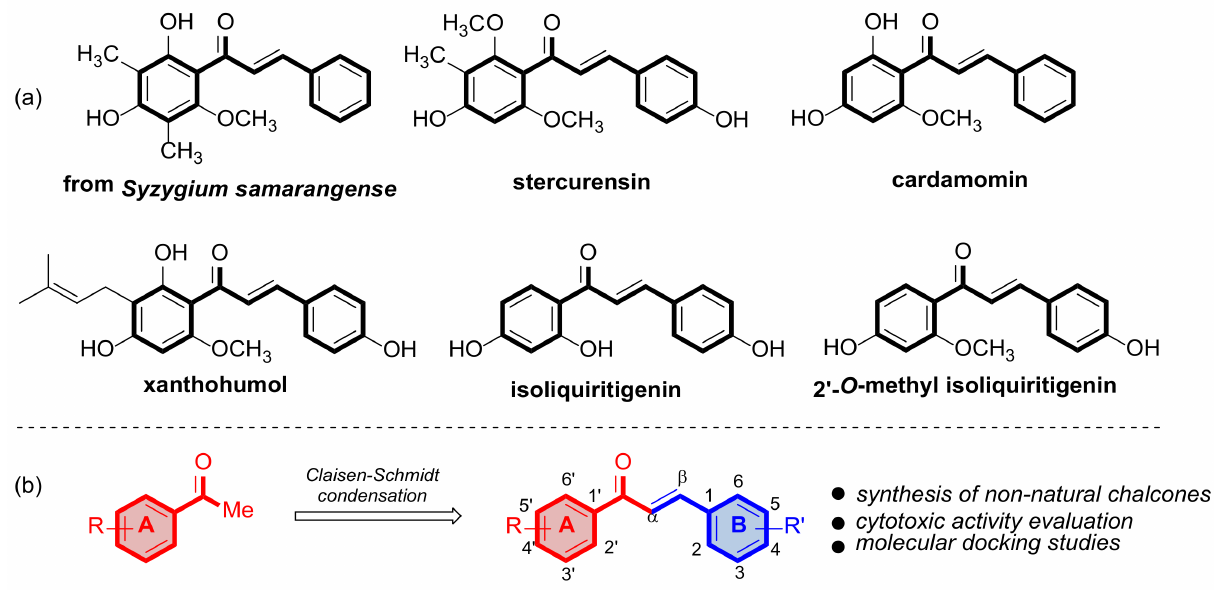
Figure 1. ( a ) Chalcones of natural origin with antiproliferative activity in various cancer lines. ( b ) Strategy to synthesize chalcones using a Claisen–Schmidt